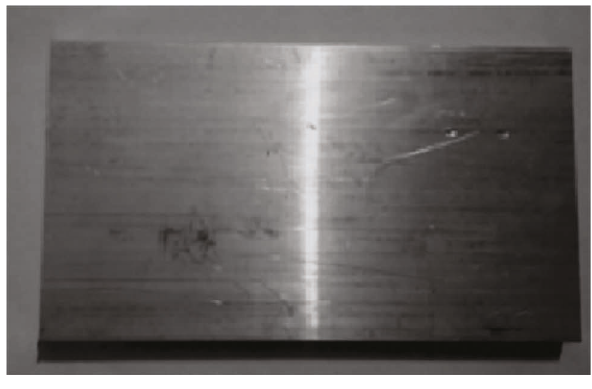
Figure 1: Workpiece. Table 1: Chemical composition of aluminium alloy 6082.